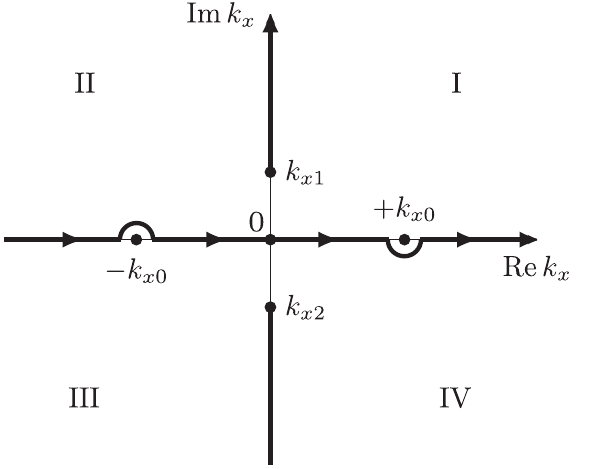
FIG. 3. The complex plane χ : initial integration path, the poles (cid:3) χ χ Γ (cid:2) 0 , the saddle point s þ , and the steepest descent path þ (for x > 0 ). Roman numerals designate the areas, which correspond to the quadrants of the physical sheet of the complex plane k x